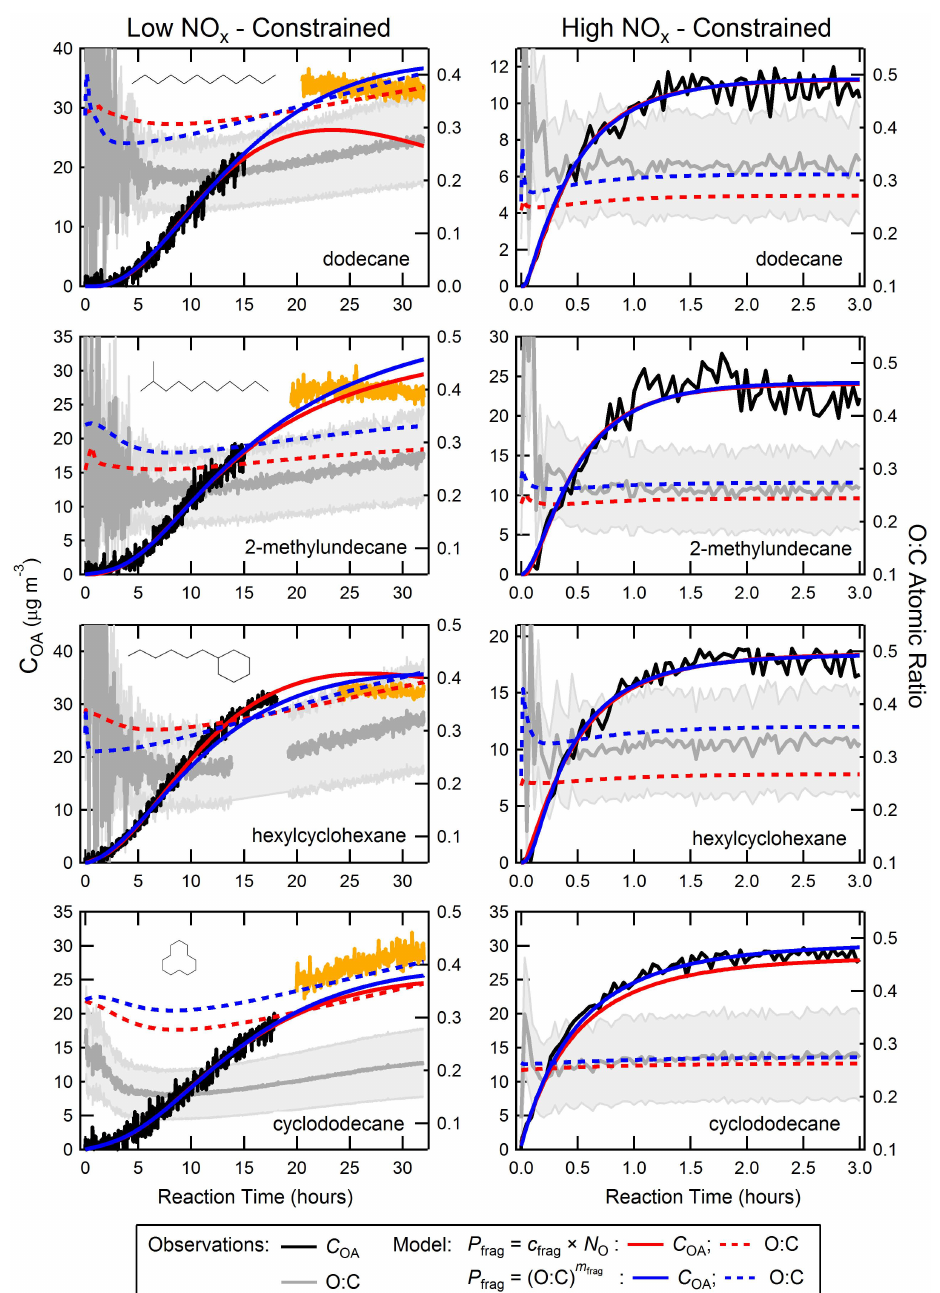
Fig. 8. Same as Fig. 1, but where the high-NO x and low-NO x c frag and m frag parameters have been constrained; see text for